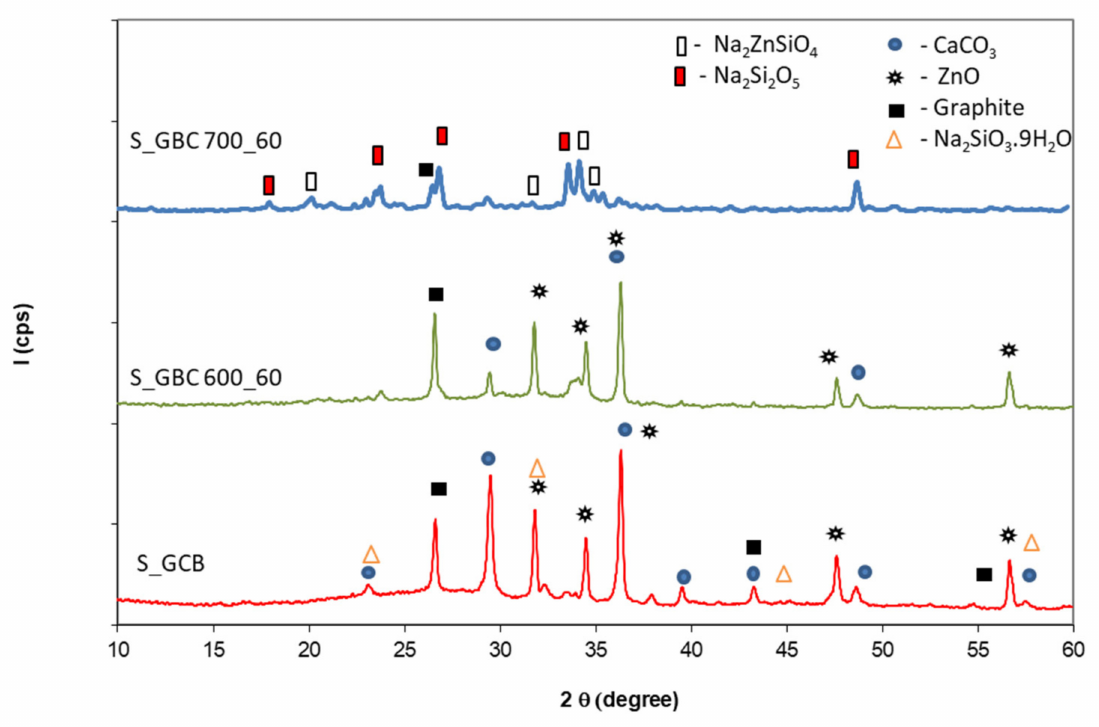
Figure 8. XRD patterns of the coating with GB and graphite addition before and after thermal treatment at 600 ◦ C and 700 ◦ C for 60